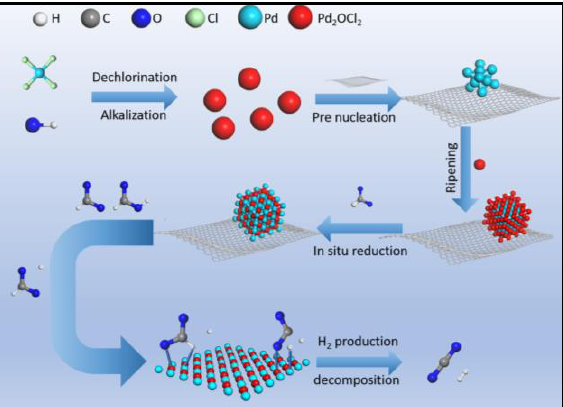
Scheme 1. Strategy of coupling pre-nucleation with in situ reduction for preparing Pd/C catalyst toward high speed and selectivity formic acid dehydrogenation.